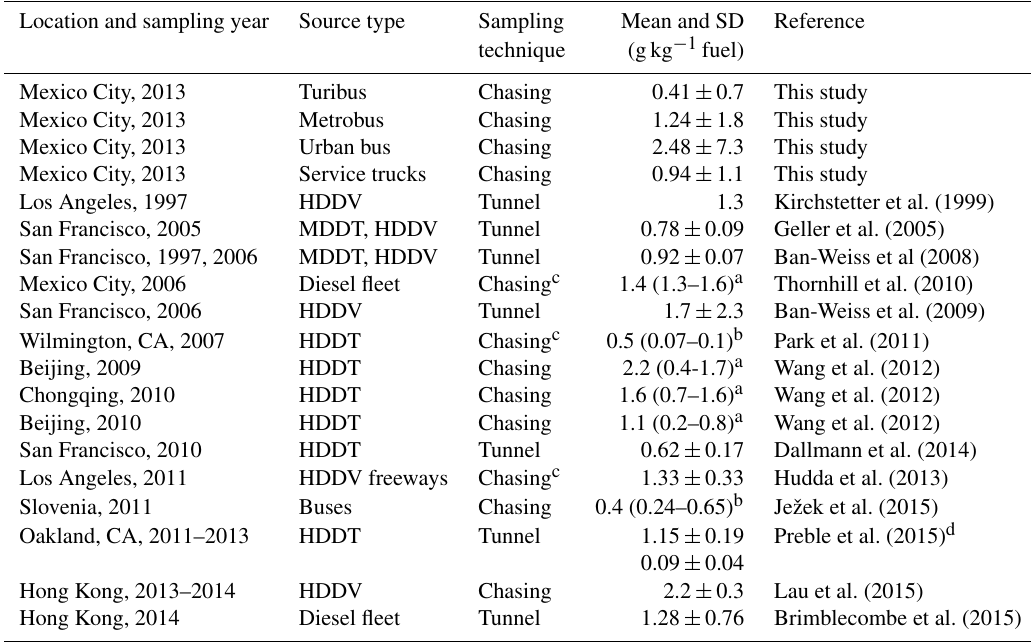
Table 3. Comparison of measurements of BC emission factors from diesel-powered sources. Location and sampling